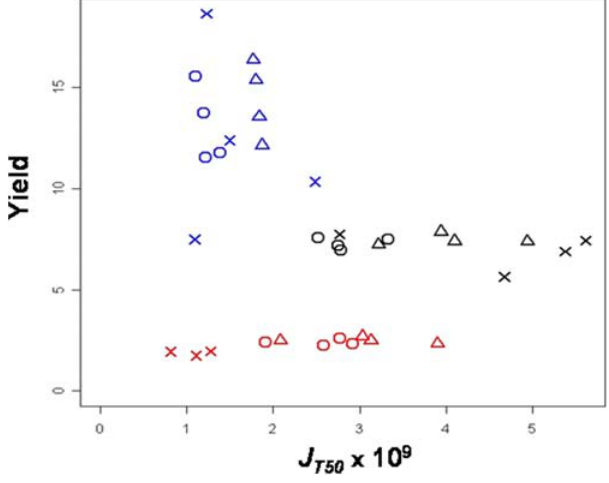
Figure 6. Relationship between yield and glucose consumption rate. Yield is defined as the ratio of the biomass (product of carrying capacity by cell size) to the initial glucose amount in the medium. Each point corresponds to the mean value of a strain in a culture condition. Blue, black and red colors correspond respectively to 0.25%, 1% and 15% glucose. Vinery strains are represented by circles, brewery ones by crosses and bakery ones by triangles.